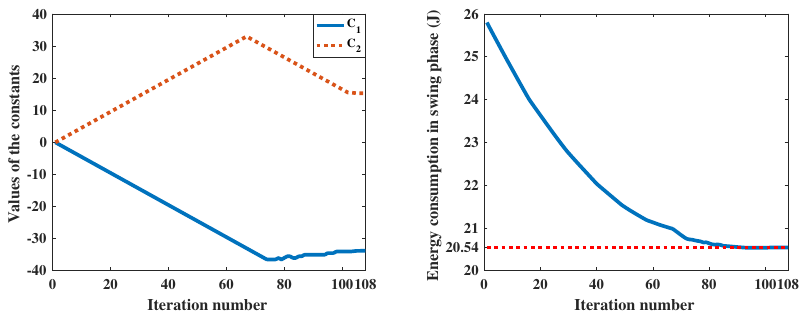
( b ) The values of the objective function during iteration Figure 8. The optimization process of RF leg by using the PS (Pattern Search) method.